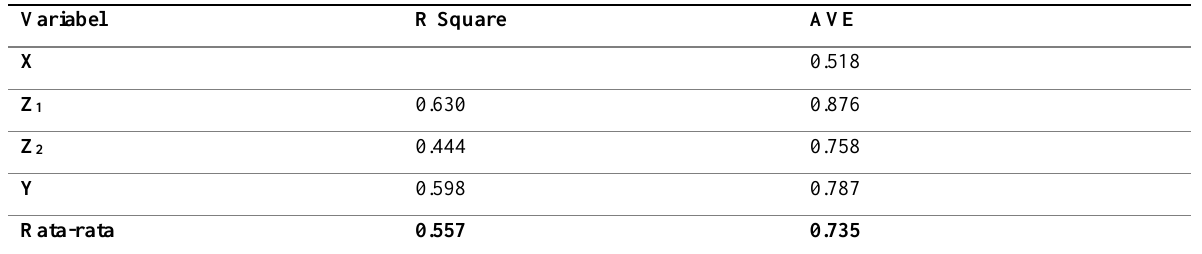
Table 6: Evaluation of Goodness of Fit